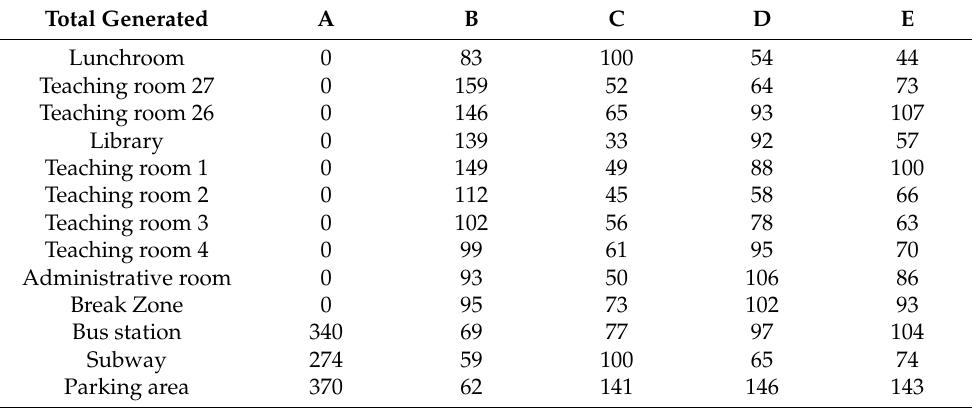
Table 2. Total daily internal path generated by each time and space interval.